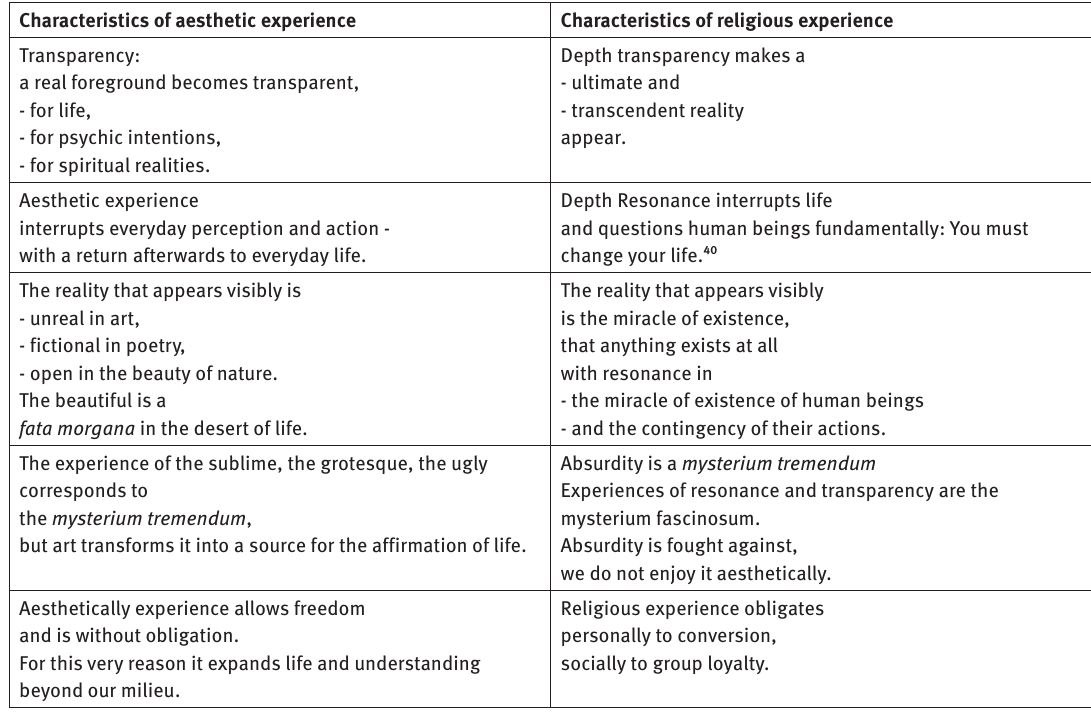
Table 2. Comparison between aesthetic and religious